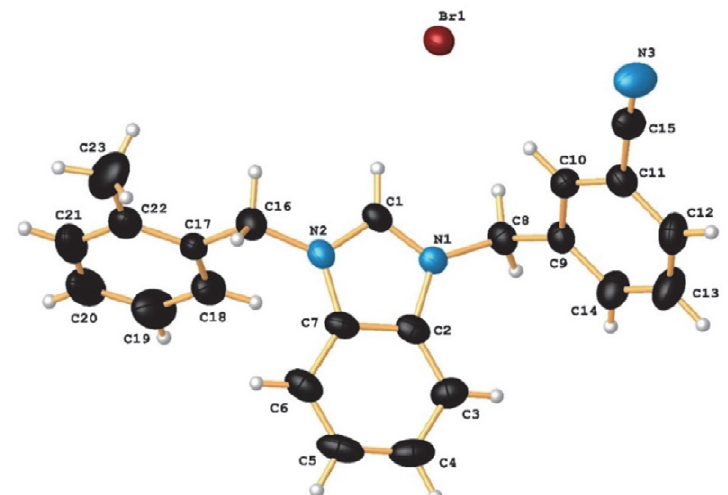
Fig. 1. Structure of 2b with ellipsoids plotted at 30% probability. Selected bond parameters (Å,°): N1–C1 1.327(6), N1–C2 1.389(5), N1–C8 1.472(5), N2–C1 1.326(5), N2–C7 1.389(6), N2–C16 1.459(6), N3–C15 1.138(7); N1–C1–N2 111.0(4), C1–N1–C8 125.6(4), N1–C8–C9 113.2(4), C2–N1–C8